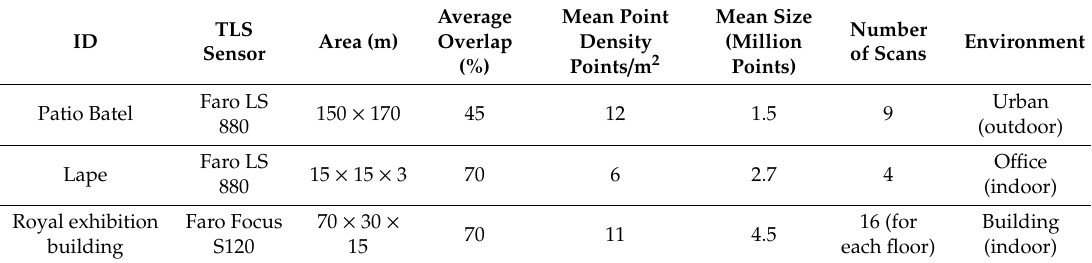
Table 1. The core specifications of the TLS sensors and outdoor / indoor